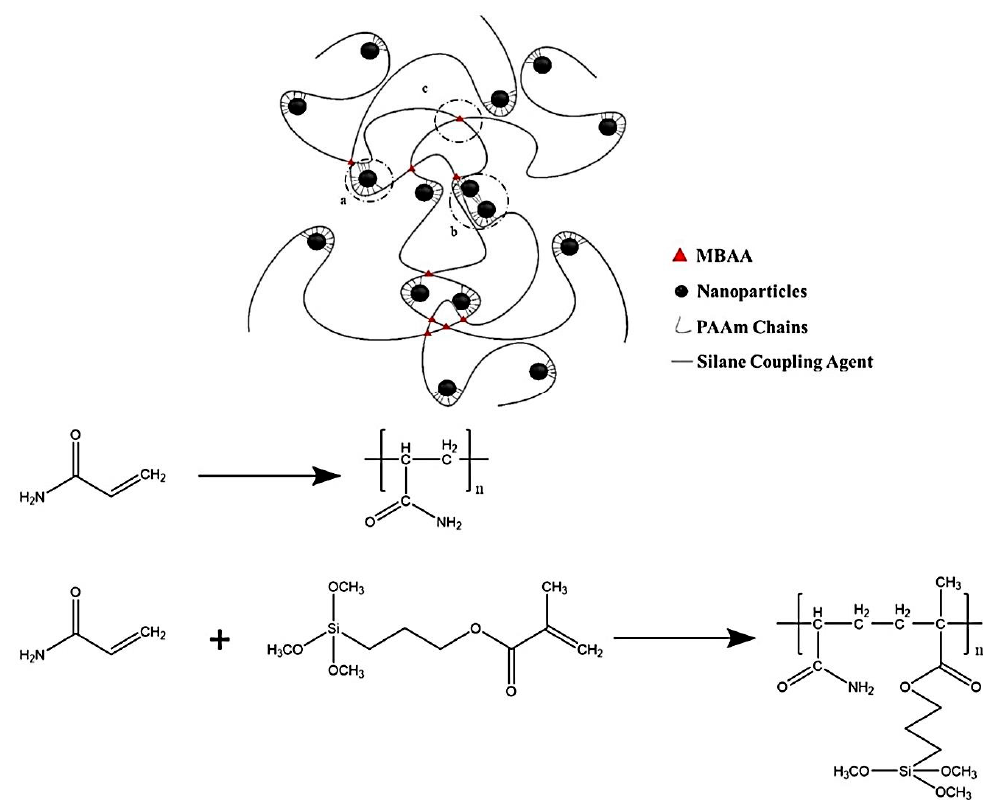
Figure 4. Schematic representation of MNP-blended hydrogel for soft robotics [96] © 2021 American Chemical Society.